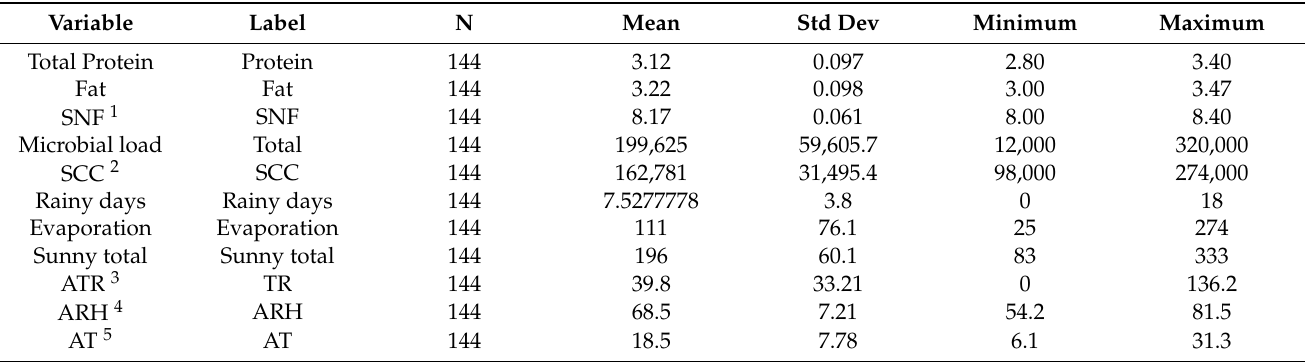
Table 1. Descriptive statistics of milk composition, microbial load, and somatic cell count in milk for the period